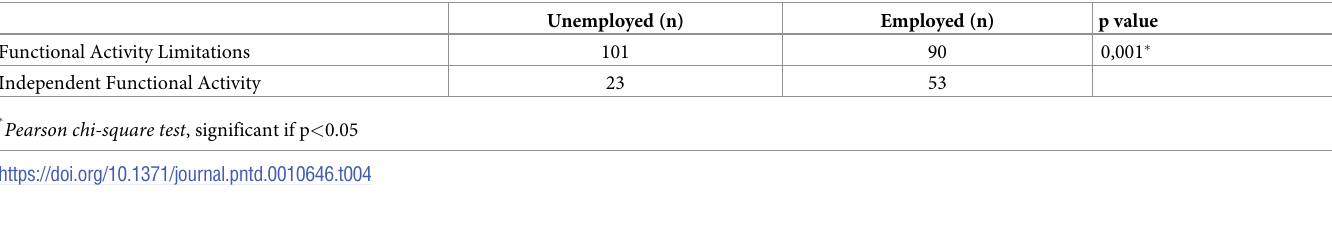
Table 4. Correlation between Functional Activity and Occupation